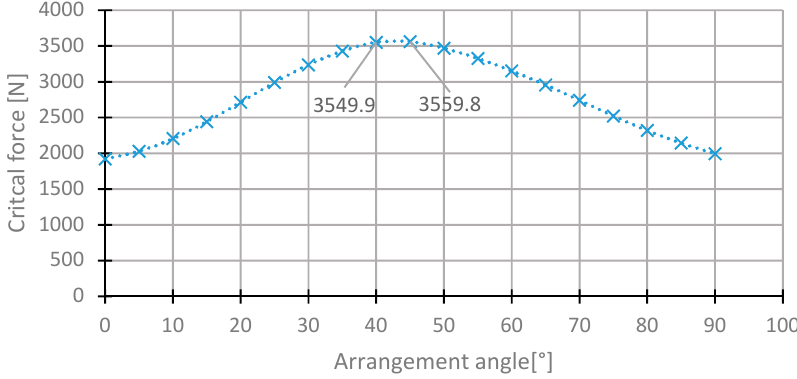
Figure 7. The critical force depending on the angle in the first layer of the [45/ − 45/ − 45/45] arrangement.